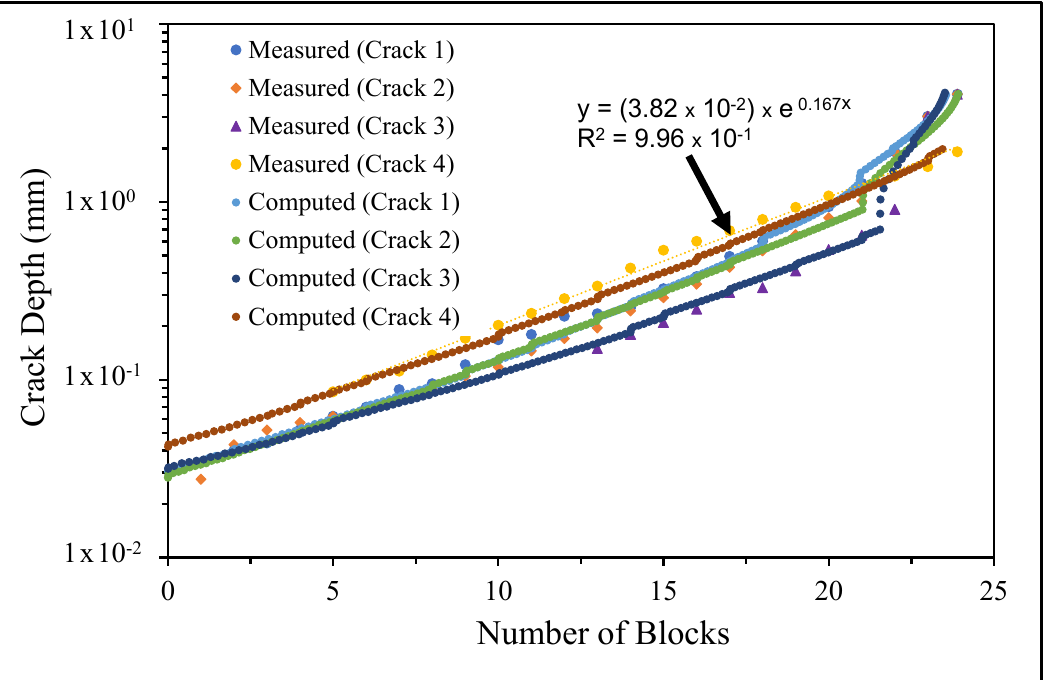
Figure 8. Measured and computed crack growth histories for specimen 1.